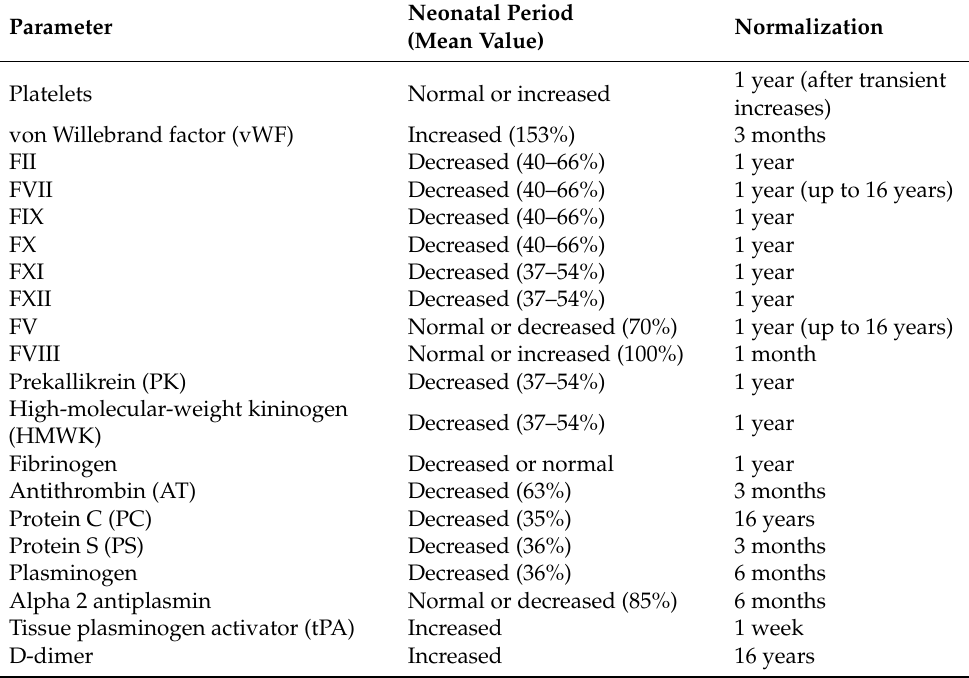
Table 4. Coagulation parameters in neonatal and childhood vs. adult